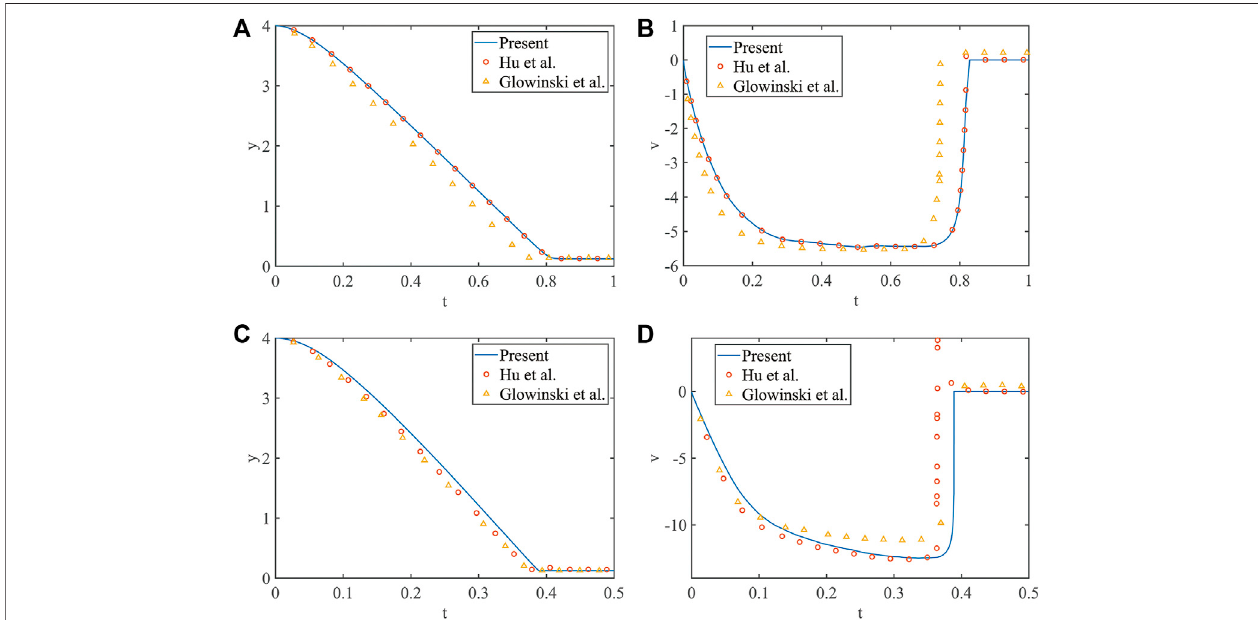
FIGURE 5 | The position of the center of the particle for ρ p (cid:2) 1 . 25 g / cm 2 , ] (cid:2) 0 . 1 cm 2 / s (A); ρ p (cid:2) 1 . 5 g / cm 2 , ] (cid:2) 0 . 01 cm 2 / s (C) , and the velocity of that for ρ